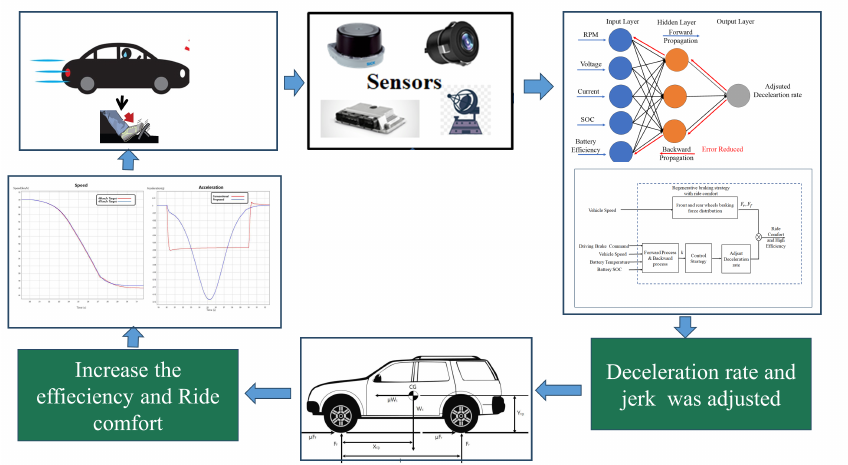
Figure 9. Schematic representation of neural networks controlling the vehicle.